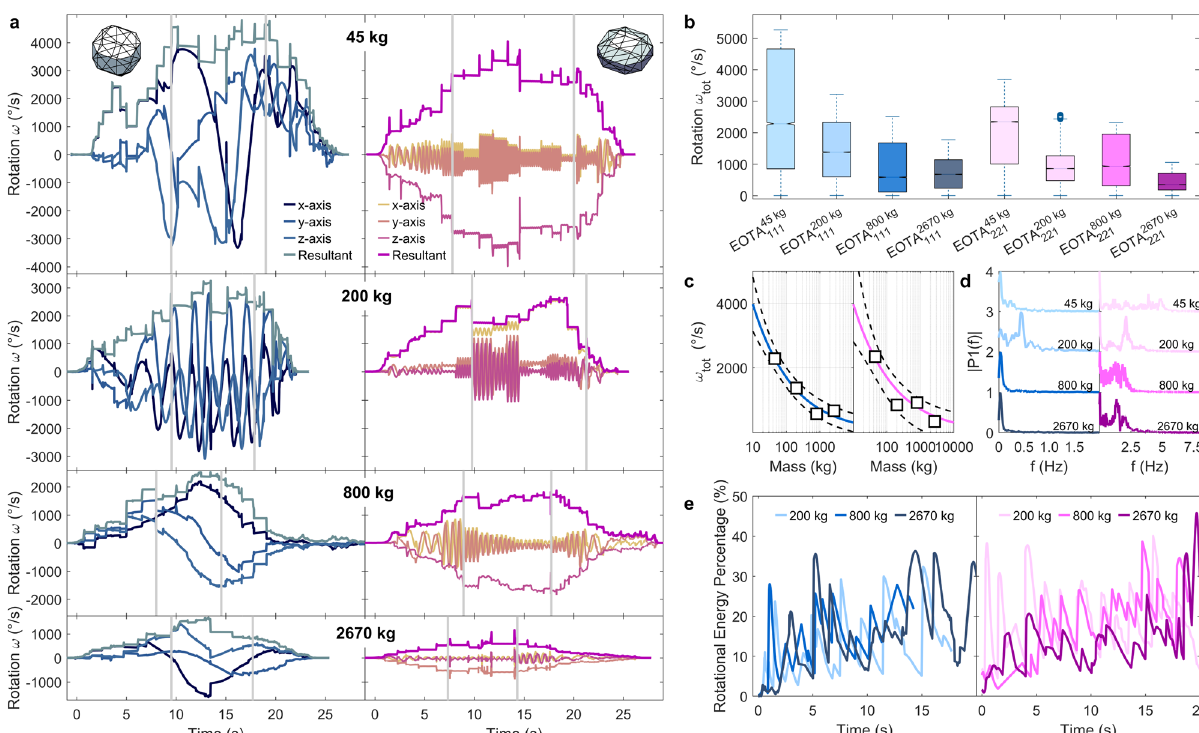
Fig. 4 Gyroscope data streams across all shape and weight classes and their derived benchmark measures, such as median rotational relationship, wobbling frequencies, and energy ratios. a Gyroscope data streams for all measured rock shapes and masses. Grey lines separate the acceleration zone above the cliff, transition zone between cliff and scree, and scree runout zones. Individual lines represent x- , y- , z -axis as well as its resultant angular velocities (thicker line). Decreasing maximal rotational speeds with an increased moment of inertia along with the almost exclusive uni-axial rotations around the principal axis for wheel-shaped rocks is visible, i.e. almost perfect overlap between the leading axis and resulting axis apart from the acceleration phase. Here, different colour shades represent different rock axis. b Summary boxplot — median values with standard whisker coverage of 99.3% (2.7 σ ) — of the StoneNode gyroscope output from the entire Chant Sura experimental campaign with its median rotational relationship as a possible benchmark indicator for unobstructed slopes plotted in ( c ). d Wobbling frequency components of descending rocks. e Rotational energy percentage of the presented runs in ( a ). Colour code for b – c is equivalent to Fig. 2: Blue markers represent equant rocks varying from 45 kg (light blue) to 2670 kg (dark blue), Wheel-shaped rocks are shown in magenta with masses from 45 kg (light magenta) to 2670kg (dark